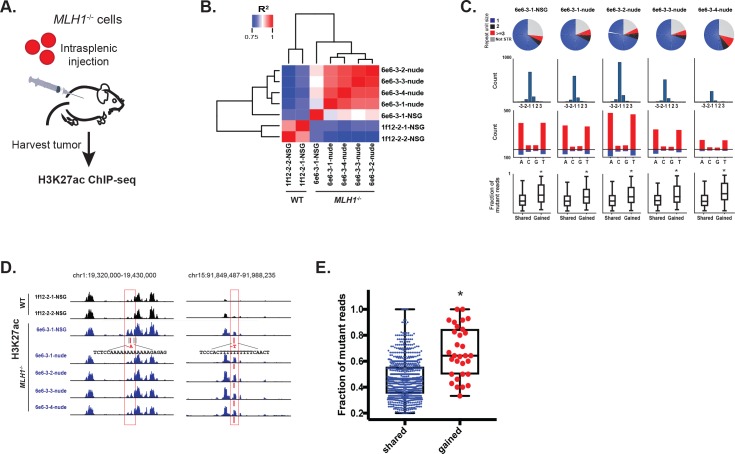
MSI enhancer indels are propagated in tumors.(A) Overview of mouse tumor formation assay. (B) Heatmap of R2 values from Pearson correlation of H3K27ac signal at enhancers. (C) (top) Pie charts show distribution of types of mutations (mono-, di-, tri-nucleotide or higher, and non-short tandem repeat). (2nd row) Histogram of indel sizes. (3rd row) Bar plots of homopolymer indel frequency by mononucleotide repeat. (bottom) Boxplots of the mutant allele fraction distribution for indels in gained peaks and peaks shared with wildtype tumors. *p<0.001, Wilcox ranksum test. (D) Genome Browser snapshots of indels (red bars) detected in MLH1-/- tumors and associated with increased H3K27ac signal (left, Y-axis scales are all 0–156; right, Y-axis scales are all 0–95). (E) Dot plot of the mutant allele fraction for homopolymer indels in shared (n = 894) peaks and those correlating with gained H3K27ac enrichment (n = 31). *p<0.001, Wilcox ranksum test. See Figure 6—source data 1.10.7554/eLife.40760.020Figure 6—source data 1.Enhancer indels detected from H3K27ac ChIP-seq of tumors derived from MLH1-/- and MLH1+/+ cells introduced through intrasplenic injection into mice.